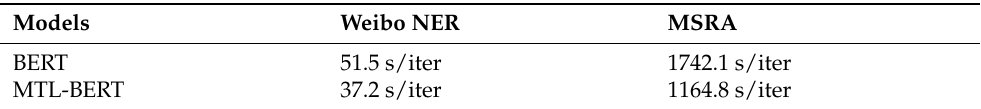
Table 7. Comparison of the experimental effects of the BERT and MTL-BERT models on an English dataset (%).